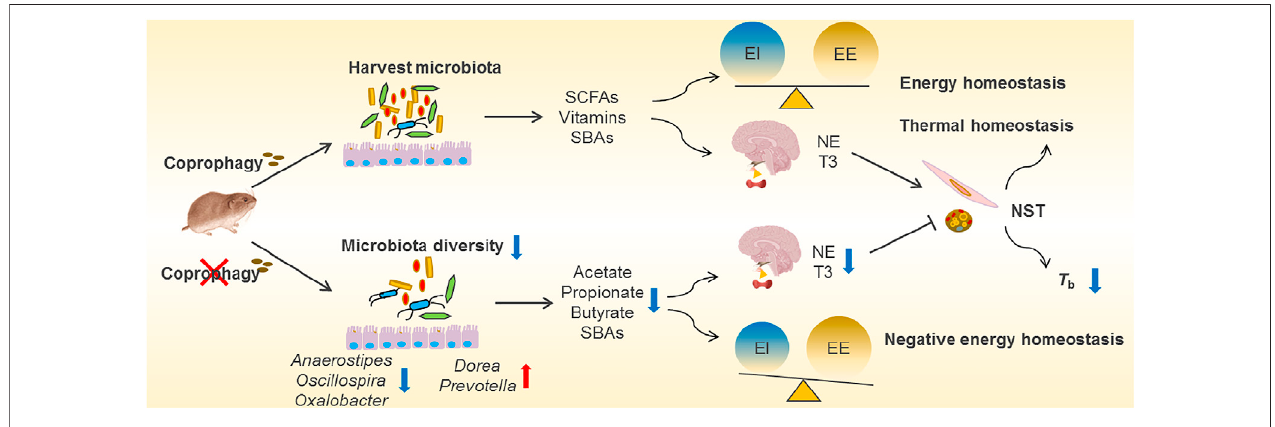
FIGURE 3 | Overview of coprophagy-associated bene fi ts in harvesting intestinal microbiota and maintaining energy and thermal homeostasis. Coprophagy prevention(CP)leadstolossofbene fi cialbacteria suchas Anaerostipes,Oscillospira and Oxalobacter forproduction ofshort-chainfatty acids(SCFAs, suchasacetate, propionate and butyrate), vitamins and secondary bile acids (SBAs), and results in the negative energy homeostasis (imbalance between energy intake, EI, and energy expenditure, EE). The de fi ciency in energy supply to the brain impairs the neuroendocrinology and leads to decreases in norepinephrine (NE) and tri-iodothyronine (T3) in CP animals, consequently leading to decreases in nonshivering thermogenesis (NST) in BAT and muscle and a drop in core body temperatures ( T b ).